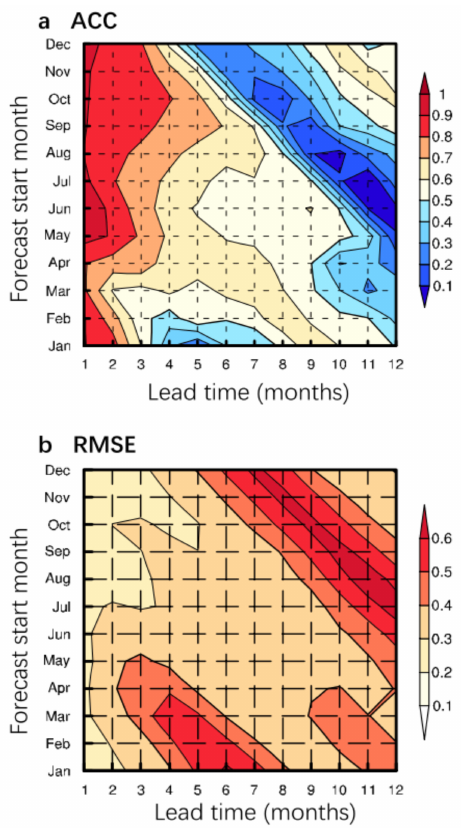
Figure 3. ( a ) The ACC of Atl3 index as a function of forecast start time spanning all the calendar months ( y -axis) and the forecast lead time ( x -axis). ( b ) same as (a), but for the RMSE of Atl3